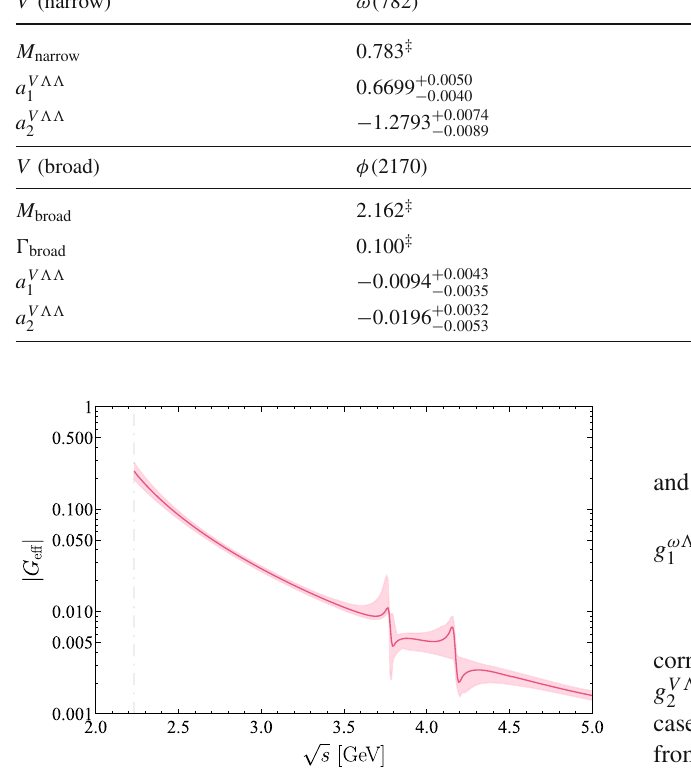
Fig. 2 The effective form factor of the (cid:2) hyperon defined by Eq. (2) from Fit-II. The error band was obtained by the bootstrap method. The ¯ (cid:2)(cid:2) threshold is indicated by the vertical dash-dotted